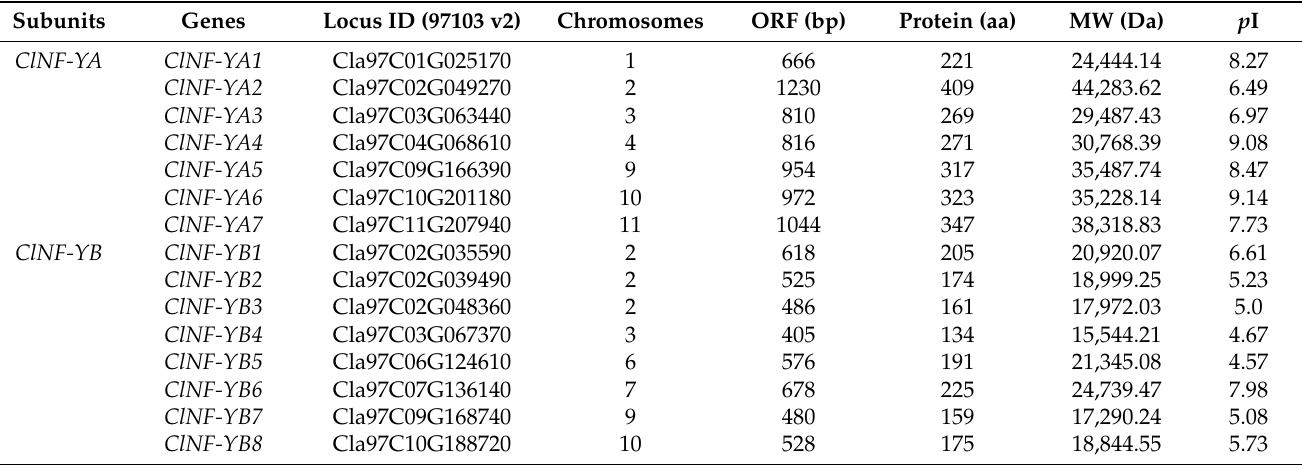
Table 1. Information on the watermelon ClNF-Y